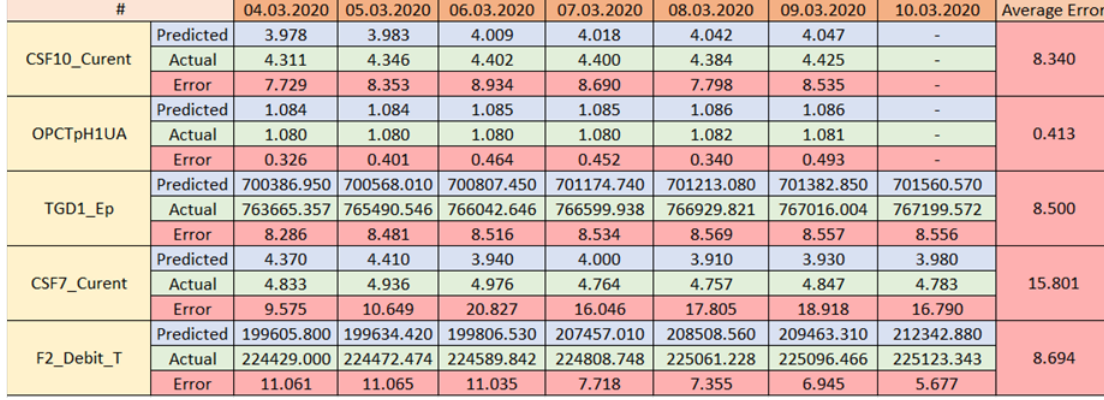
Figure 10. The most significant results of the test cases.